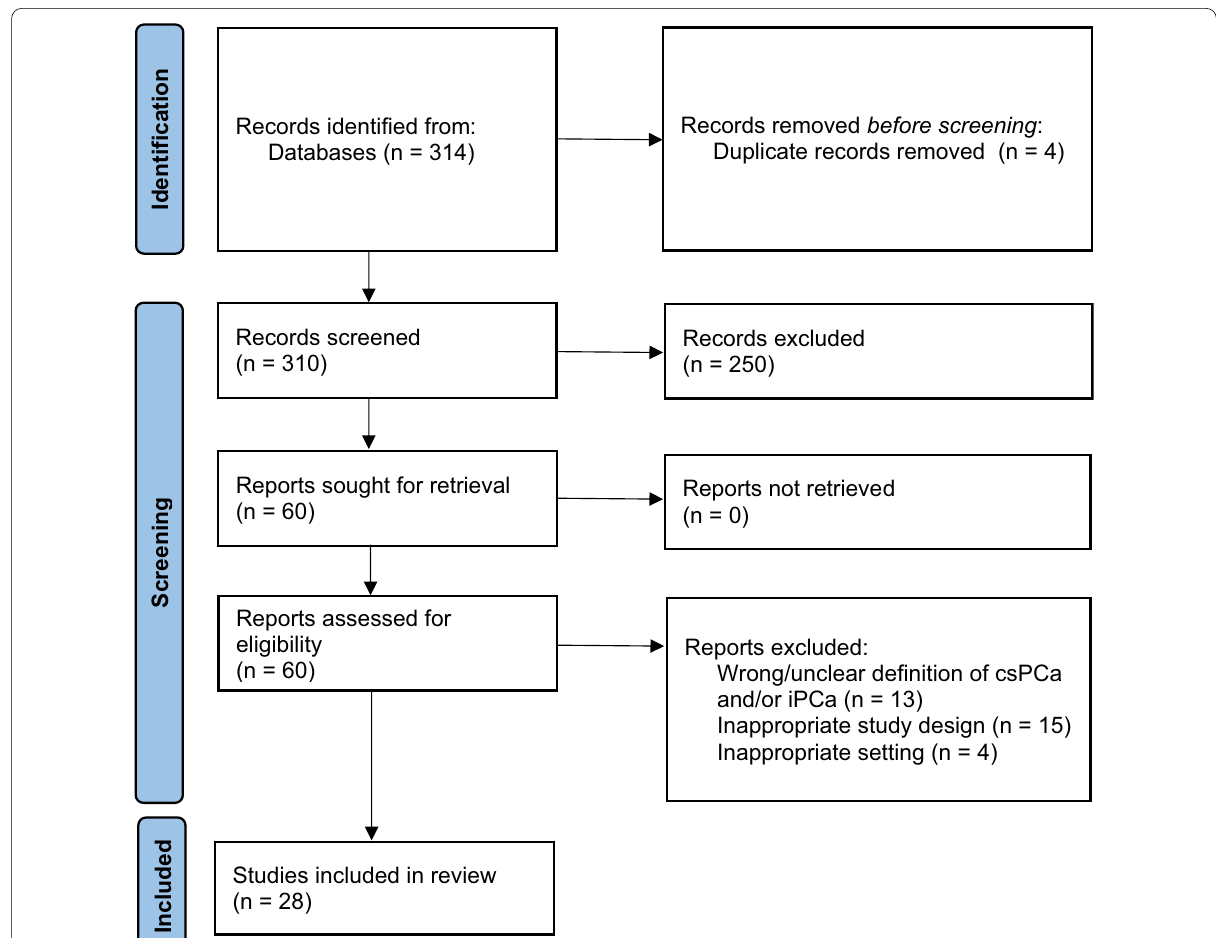
Fig. 1 Preferred Reporting Items for Systematic Reviews and Meta-Analyses (PRISMA) 2020 flow diagram for literature search. csPCa, clinically significant prostate cancer; iPCa, indolent prostate